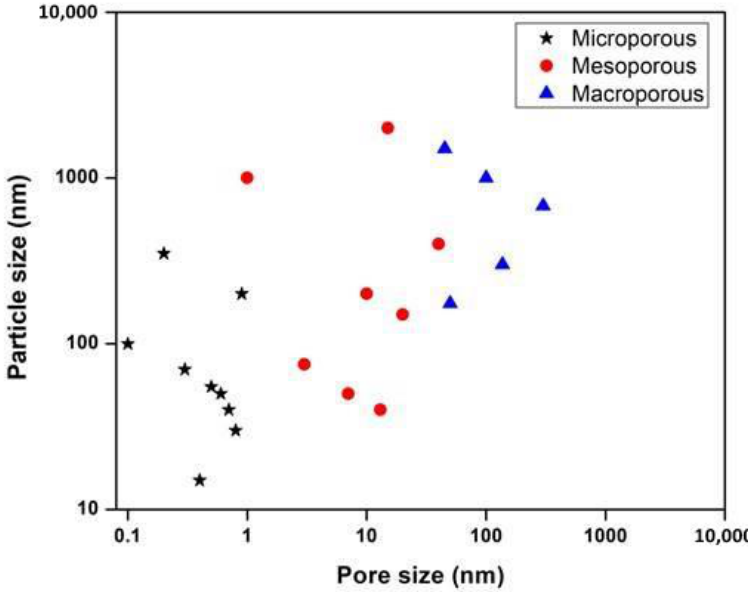
Figure 5. Plot showing different types of zeolites from Table 1, i.e., micro, meso-, and macroporous in relation to particle size and ratio of pore size and